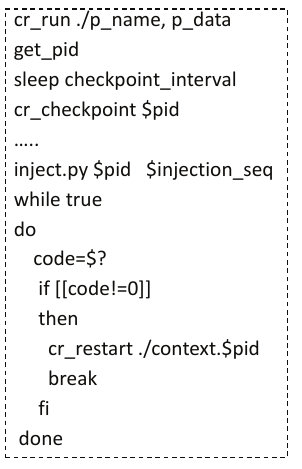
Figure 12. The pseudo-code of the procedure of checkpoint and recovery